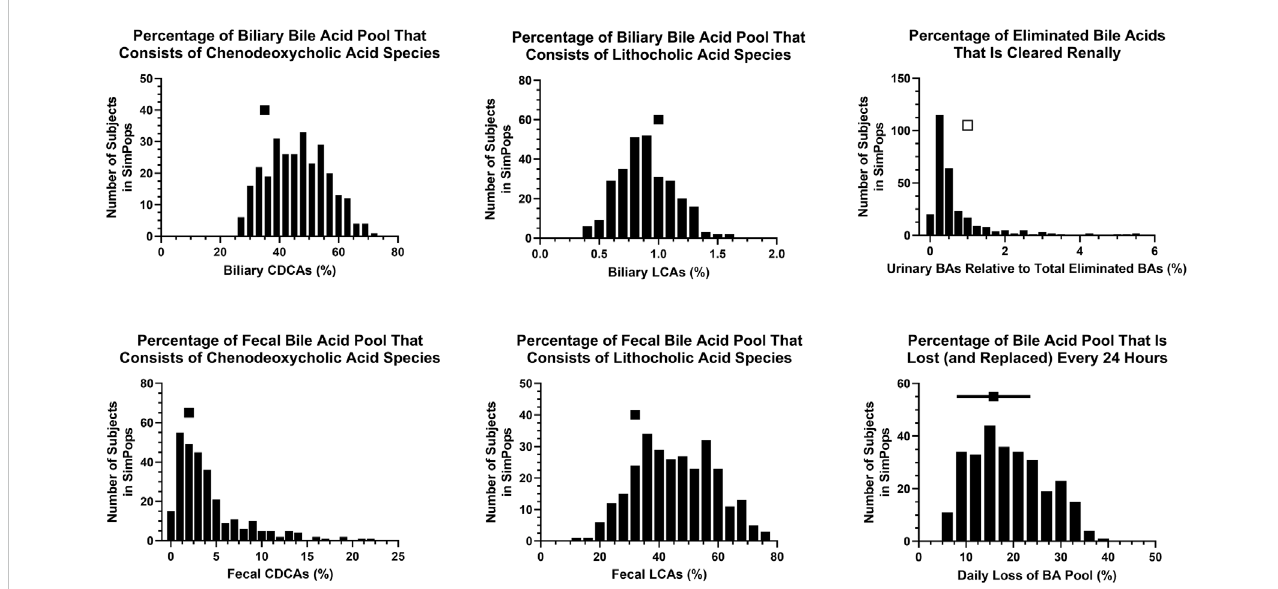
FIGURE 5 SimPops distribution of BA percentages in different matrices and/or undergoing elimination. BA, bile acid; CDCA, chenodeoxycholic acid; LCA, lithocholic acid. Clinically observed biliary and fecal data are depicted by a single solid square per panel. The percentage of eliminated BAs that is cleared renally has been reported to be < 1% (presumably in the majority of individuals), depicted by a single open square. Clinically observed mean ± SD data for the daily loss of the BA pool are depicted by a solid square and horizontal line, respectively.